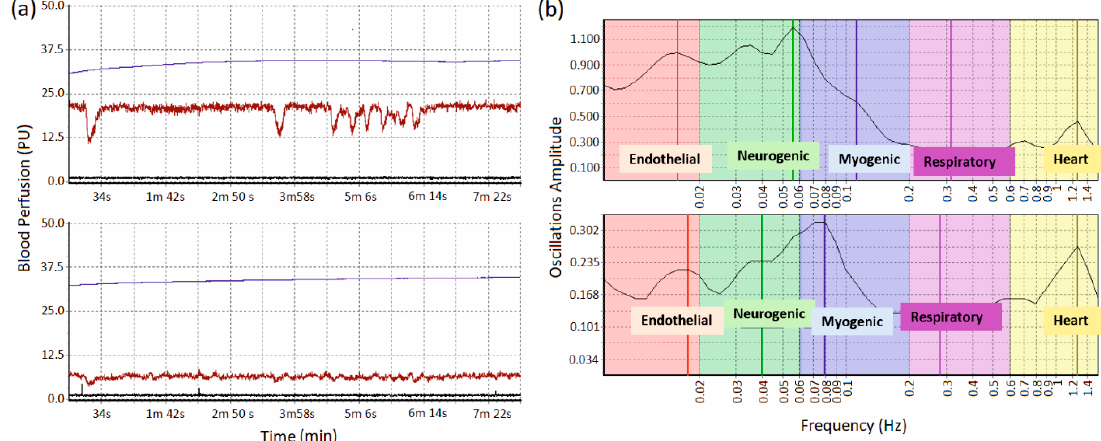
Figure 2. ( a ) Representative recordings of the blood perfusion (in brown), temperature (in blue) and accelerometric movement (in black) for left fingertip (upper) and left wrist (lower), ( b ) representative wavelet analysis for left fingertips (upper) and left wrist (lower).